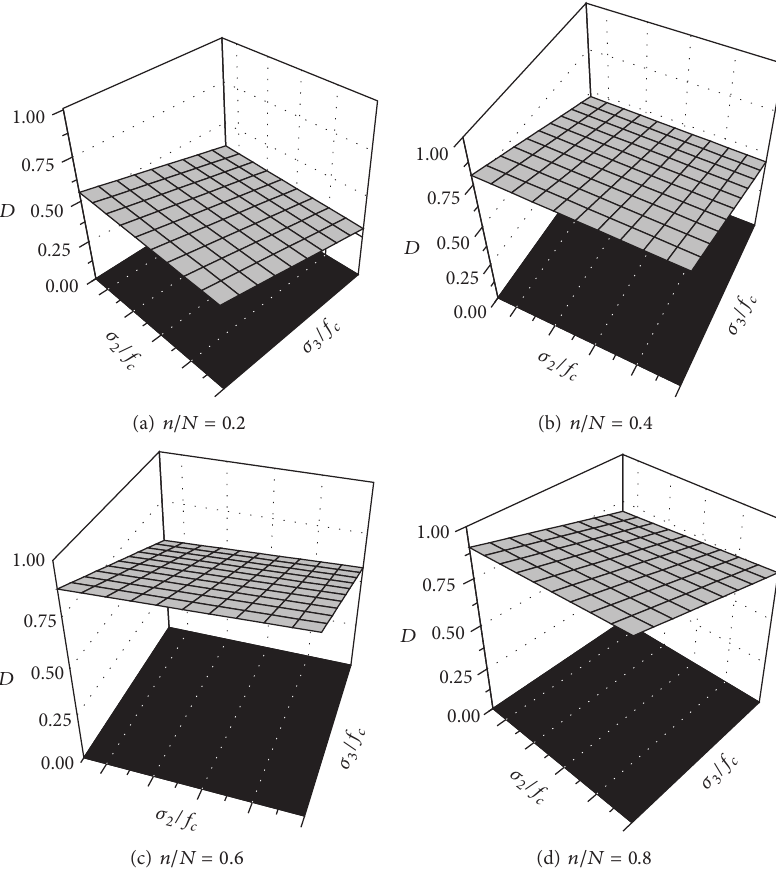
Figure 8: Relationship between damage 𝐷 and 𝜎 2 /𝑓 𝑐 , 𝜎 3 /𝑓 𝑐